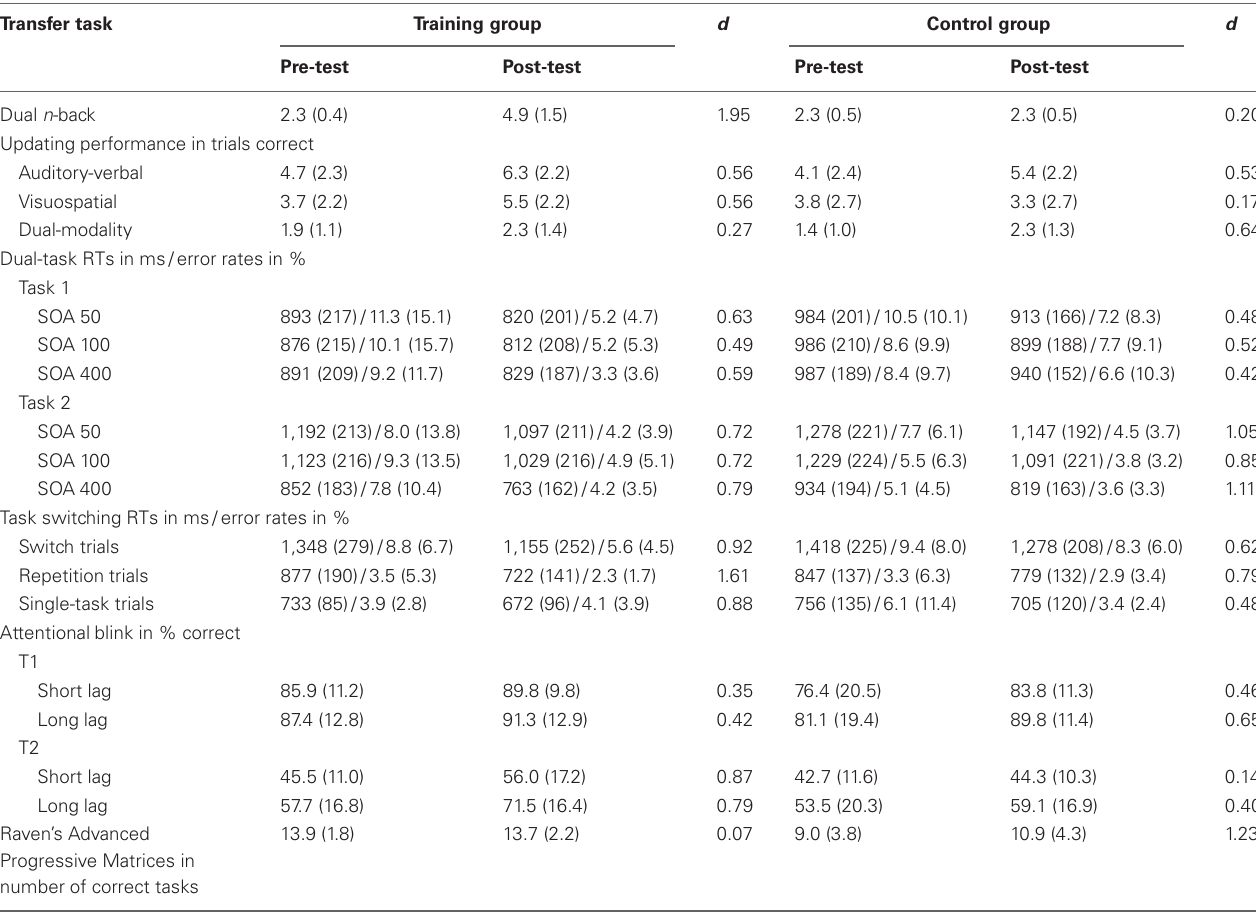
Table 1 | Pre- and post-test performance as well as the effect sizes for pre- and post-test comparisons of the training group and the control group in each transfer